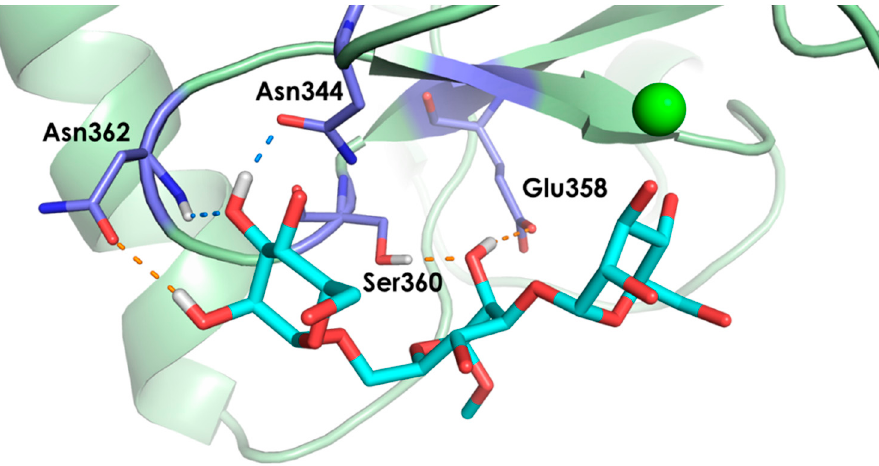
Figure 5. Possible intermolecular hydrogen bond interactions predicted by the MD simulations for the complex between DC-SIGN and the core trimannoside 1b. These hydrogen bonds (HBs) are absent in the corresponding complex with the trifluorinated glycomimetic 1. Hydrogen bonds involving OH-2 groups of Man II and Man III are colored orange, and the ones involving OH-3 are in blue. The most stable binding pose, ManI_O3-O4, was used as starting geometry.